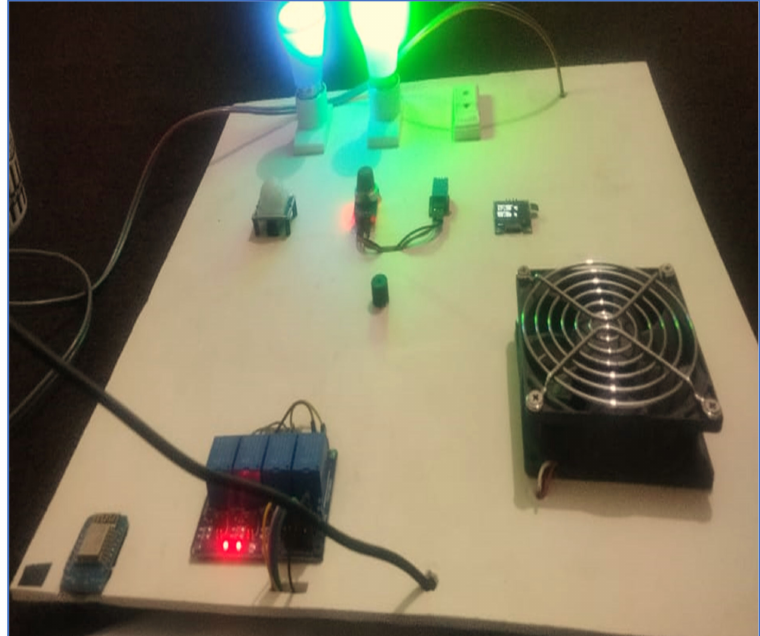
Figure 5. Working prototype of proposed system.